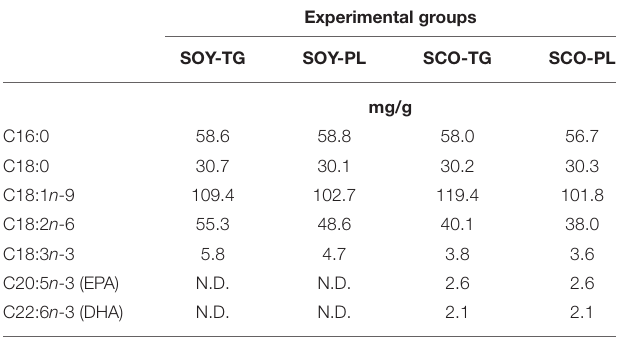
TABLE 5 | Lipid contents in the serum and liver.